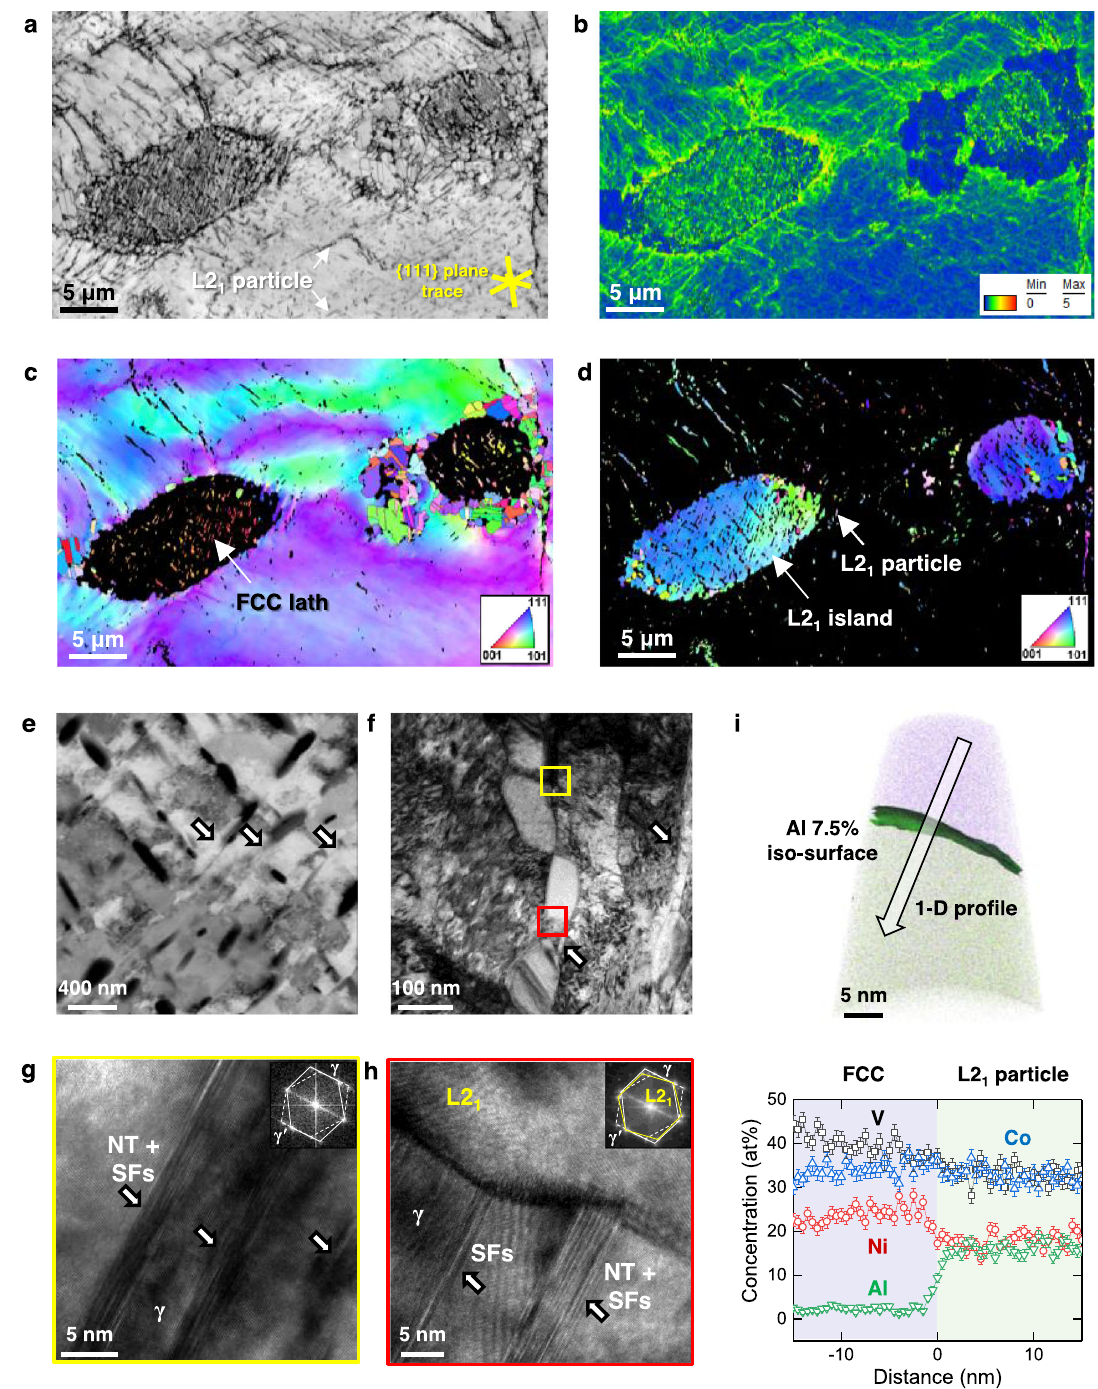
Fig. 3 The microstructure evolution in the medium-entropy Al 0.2 CoNiV alloy heat-treated at 800°C for 1 h. a Electron backscatter diffraction (EBSD) images showing quality (IQ), b kernel average misorientation (KAM), inverse pole fi gure (IPF) maps of c face-centered-cubic (FCC) and d L2 1 phases. e Electron-channeling contrast imaging (ECCI) map, f transmission electron microscopy (TEM) image of micro-shear bands and L2 1 particles in the non- recrystallized FCC grains. g , h High-resolution TEM and corresponding fast Fourier-transform (FFT) images indicate the micro-shear band consists of stacking faults and nanotwins. i Atom probe tomography (APT) tip reconstruction and 1-D pro fi le across the L2 1 and FCC matrix. The phase boundary is highlighted by a 7.5 at% Al iso-concentration surface. Each datum point stands for an average concentration measured at a 0.5 nm interval, where error bars indicate a standard